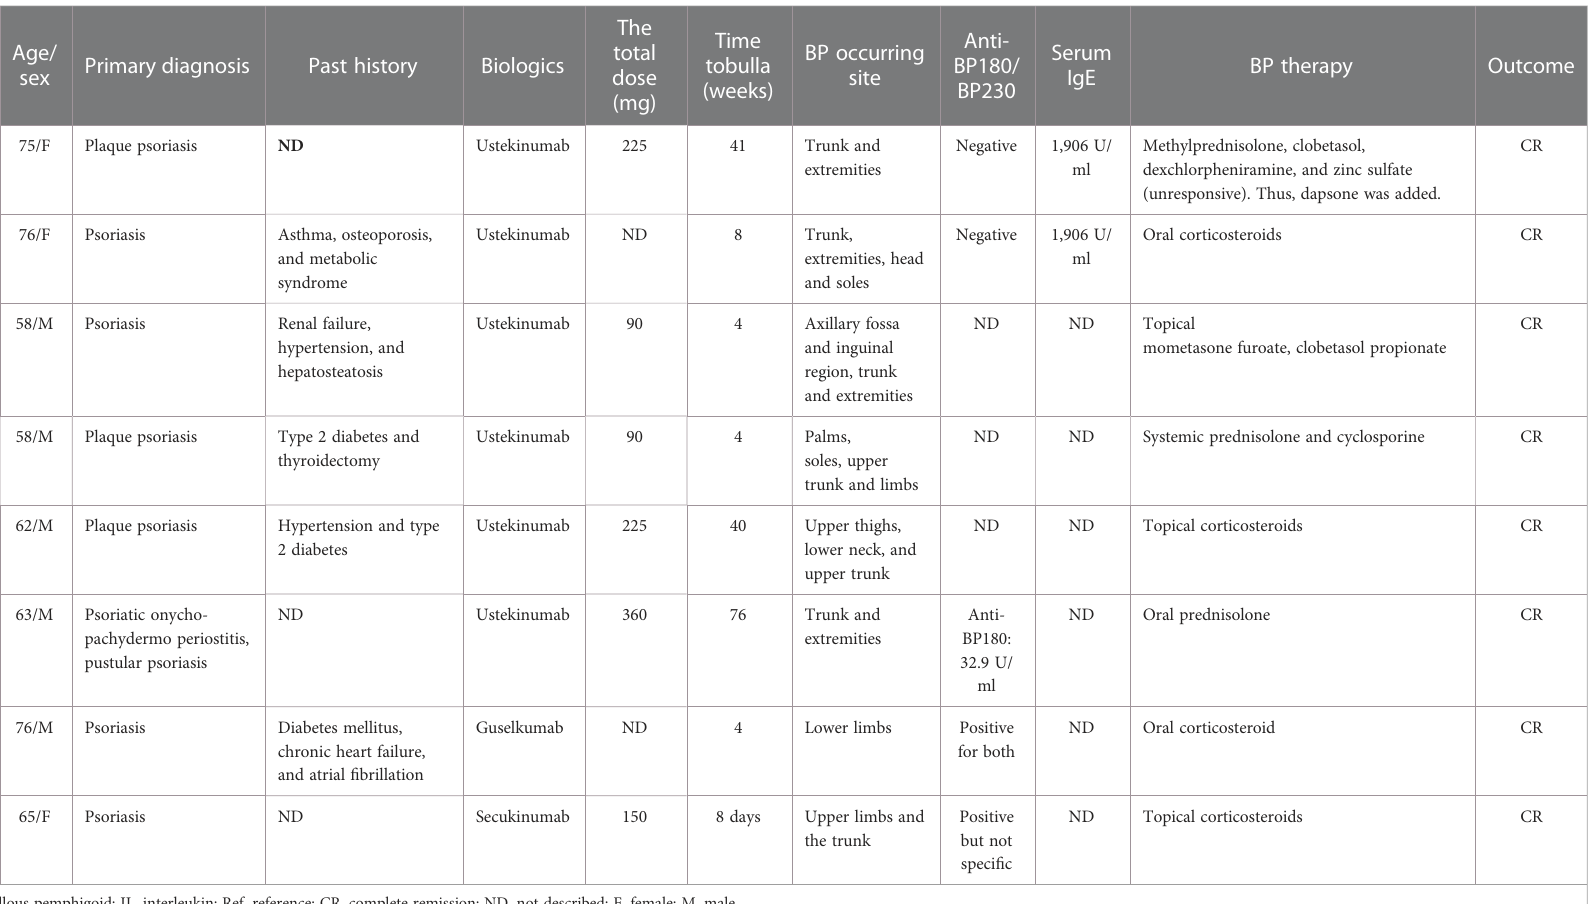
TABLE 4 Clinical characteristics of BP cases associated with IL-12/IL-23, IL-23, or IL-17